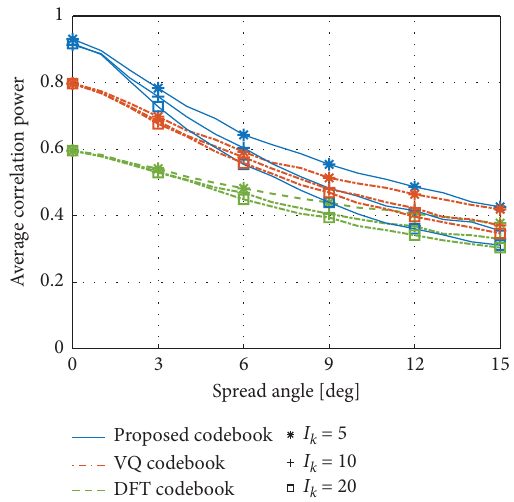
Figure 11: Performance comparison under channel parameter variations.